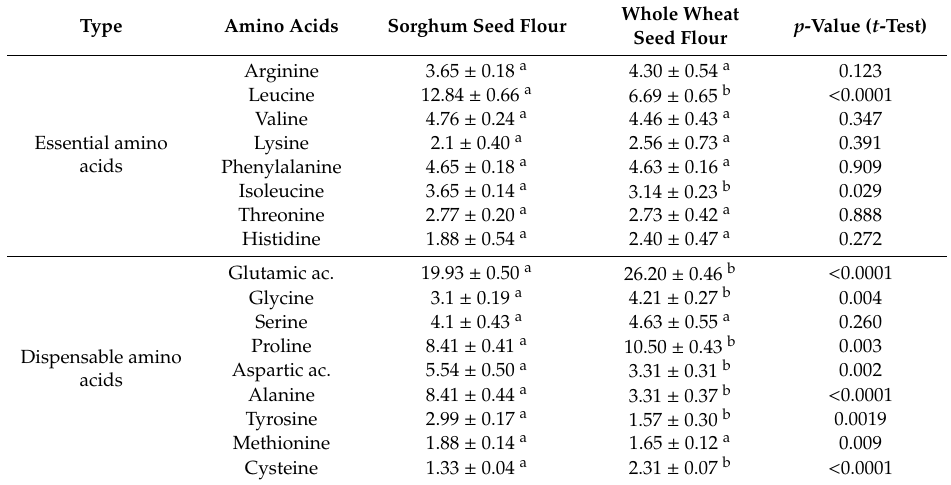
Table 4. Amino acids composition of sorghum and whole wheat flours (g amino acid / 100 g protein).